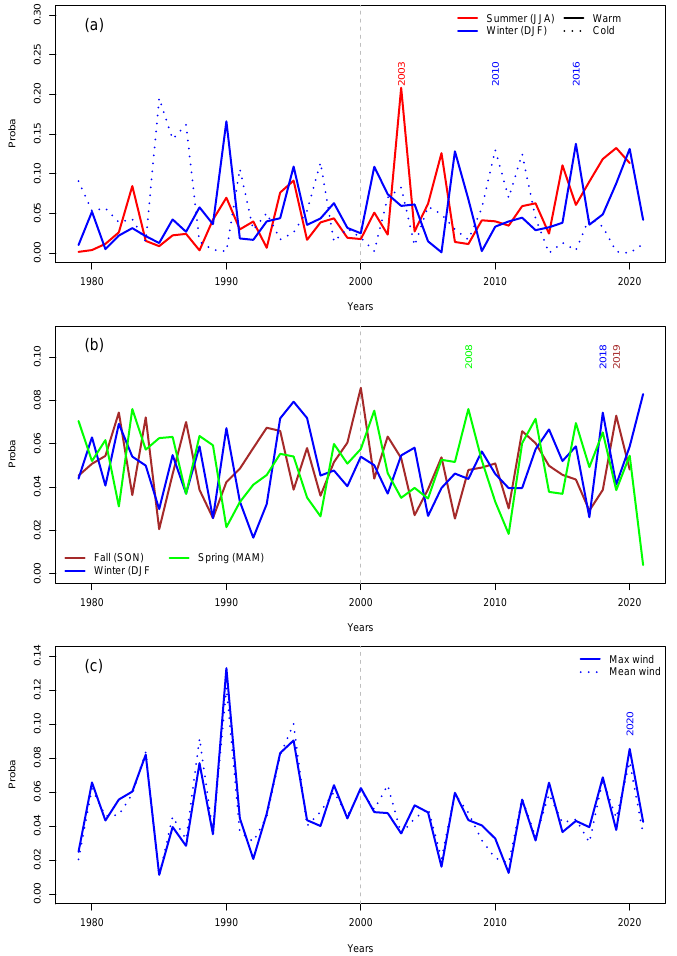
Figure 1. Variations of p ( y ) for temperature ( a ), precipitation ( b ) and wind speed ( c ). The vertical dashed line is for the year 2000 after which the events are considered. The colours indicate the seasons: red for summer, brown for Autumn, blue for winter and green for spring. The dotted line in panel ( a ) indicates the value of p when temperature is below the 5th quantile. The years indicate the records during the 21st century, but excluding